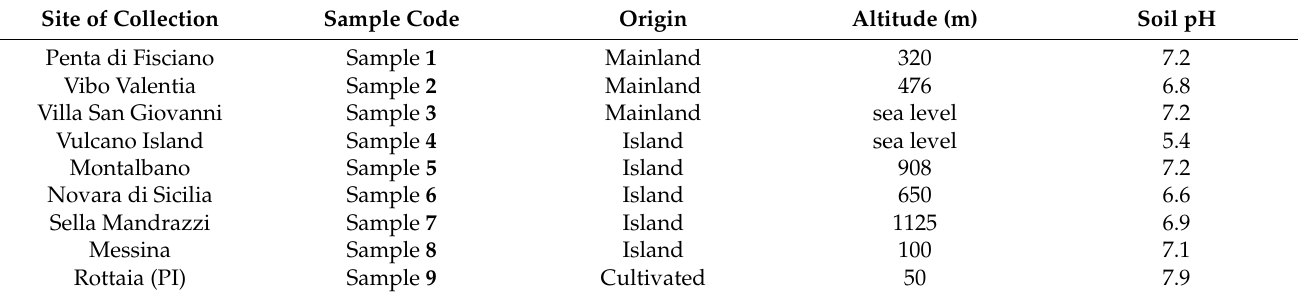
Table 4. Altitude and soil pH of the sample collection